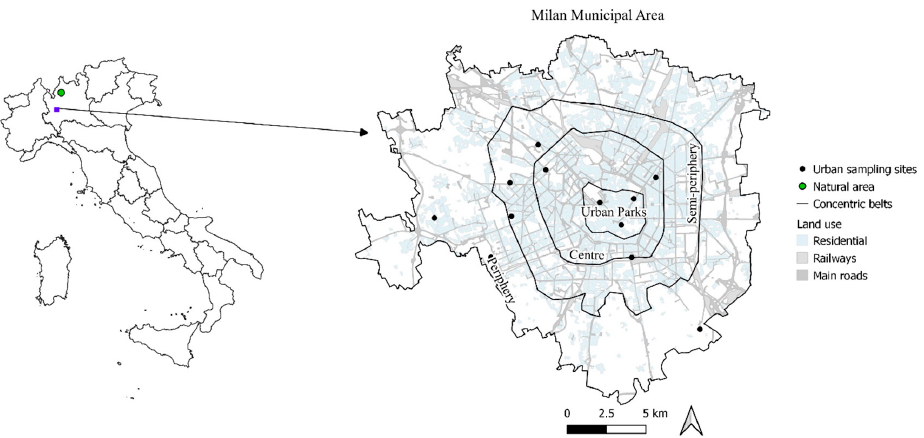
Figure 1. Map showing the location of the study area in northern Italy ( left ), the location of sampling sites (n = 12) in Milan ( right ), and the background control site ( left ).